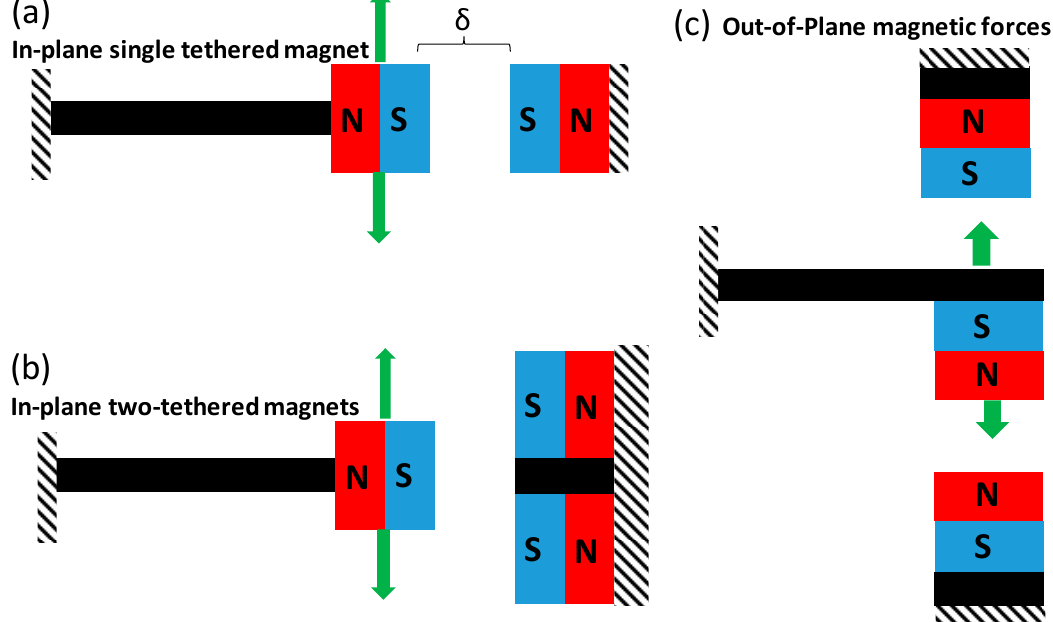
Figure 1. Schematic of magnetic configurations on a cantilever beam. Arrows represent direction of motion of cantilever beam. ( a ) In-plane single magnet configuration with δ (distance) between magnets, which can have attractive or repulsive forces, ( b ) In-plane two-tethered magnetic configuration with repulsive forces and ( c ) out-of-plane magnetic forces with tethered magnets, which can be configured with repulsive or attractive forces.